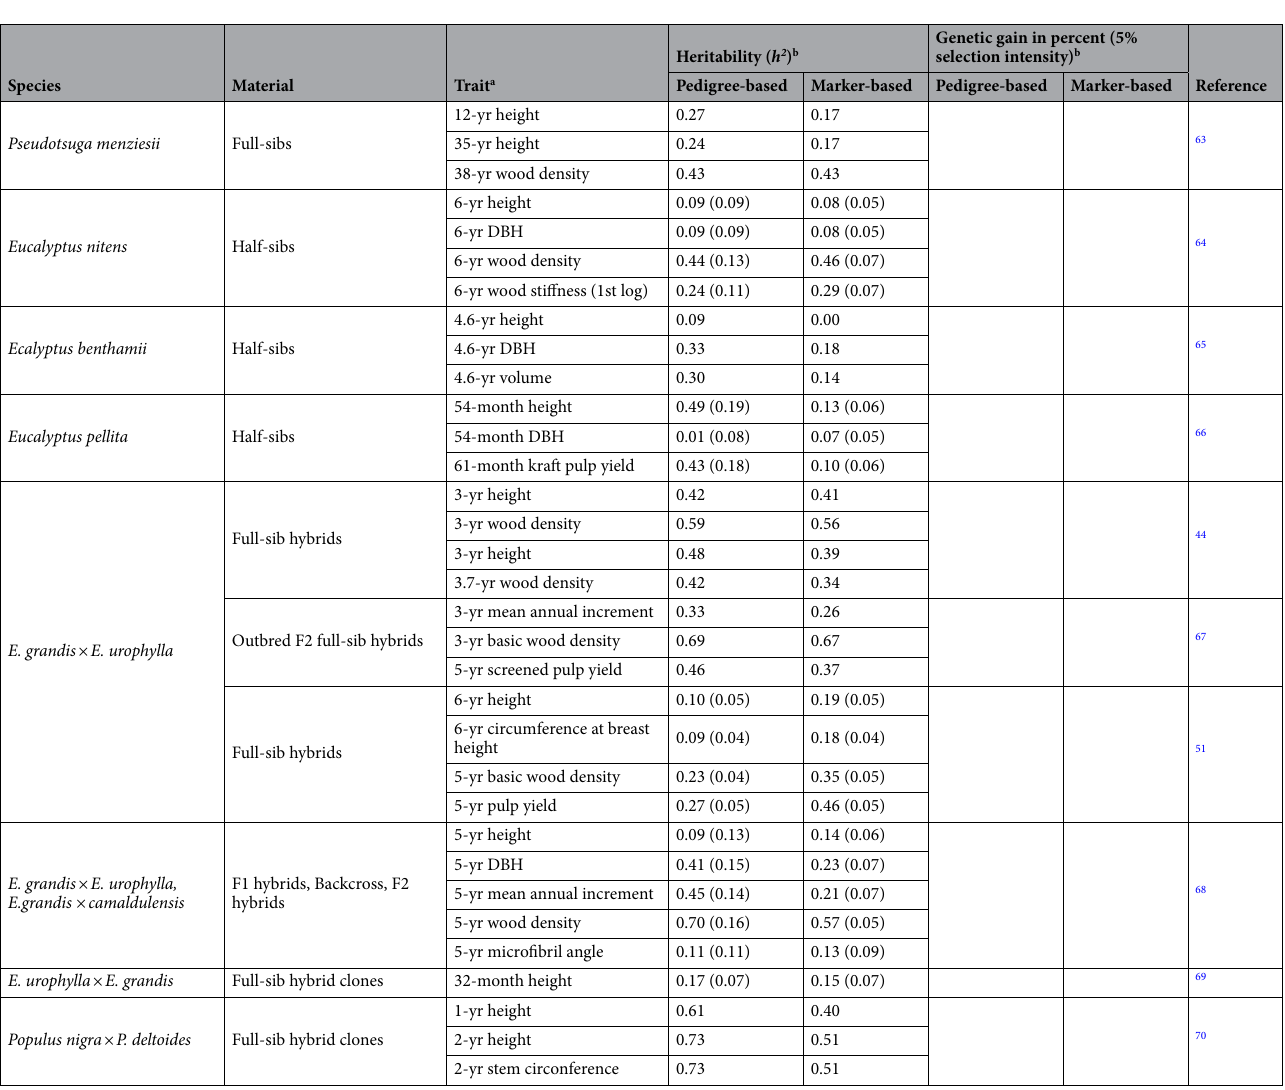
Table 1. Pedigree-based and marker-based estimates of narrow-sense heritability for a variety of traits of conifer and broadleaved tree species. a DBH = diameter at breast height. b When reported in the original papers, standard errors in